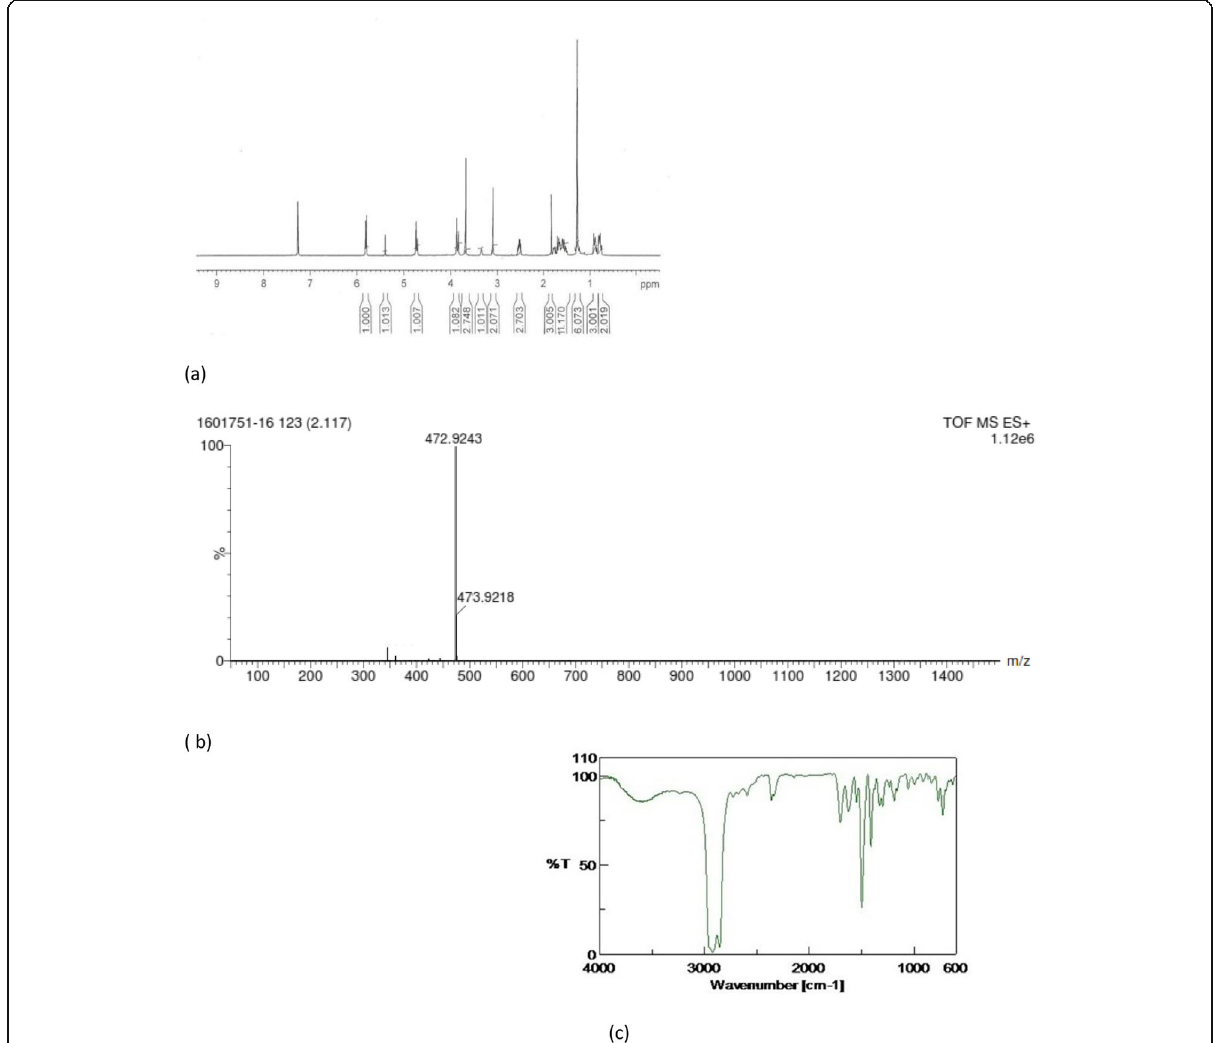
Fig. 1 The spectra of the newly isolated compound 1 from E. cotinifolia : a 1 H-NMR, b mass spectra, c